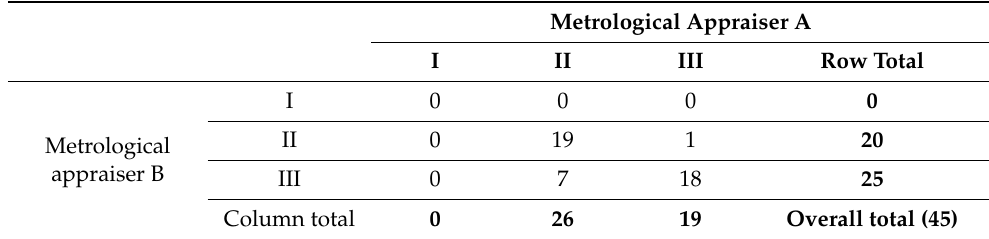
Table 12. Number of dimensional agreements/disagreements with respect to the tolerance field, metrological appraisers A and B.